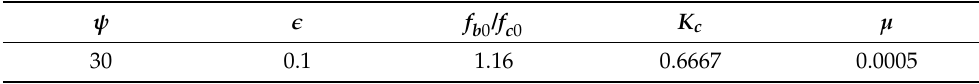
Table 2. Parameters of ABAQUS concrete plastic